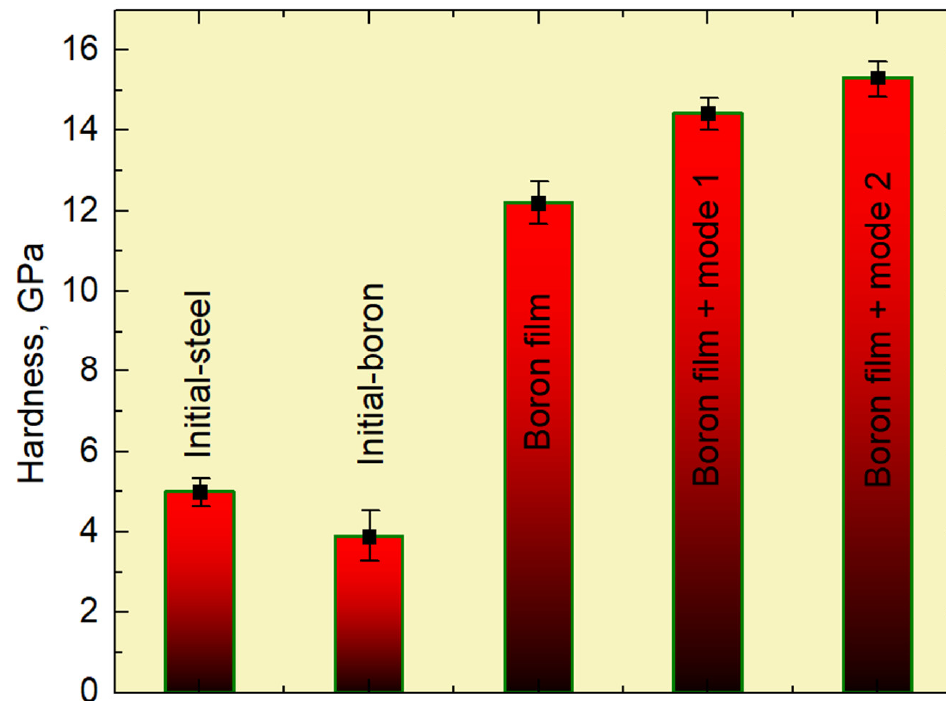
Figure 7. Microhardness of the steel substrate, the boron target, and fabricated boron coatings.